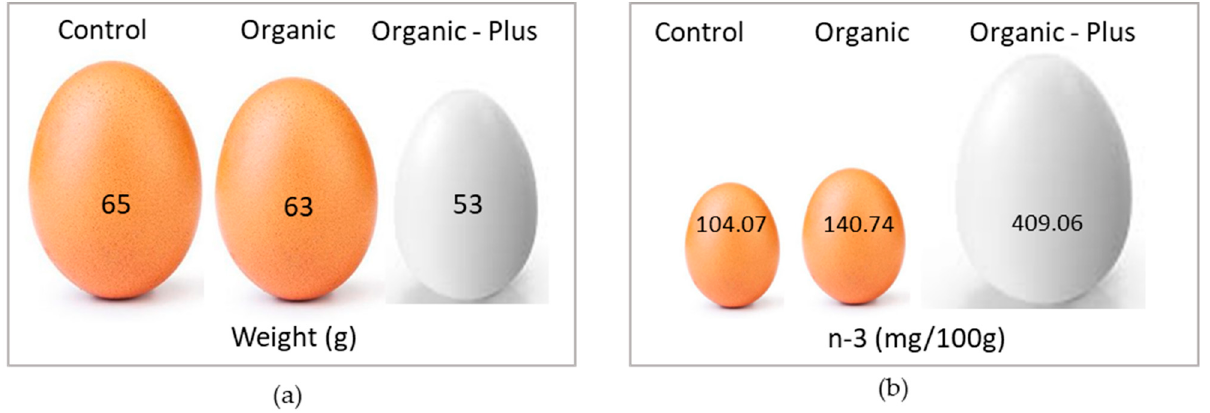
Figure 5. Comparison between ( a ) the weight (g) and ( b ) n-3 content (mg/100 g) of eggs from hens reared in conventional, organic, and organic–plus system. Conventional rearing system was characterized by commercial hens reared indoors; in the organic rearing system, commercial hens with 4 m 2 /hen of organic pasture were used, whereas organic-plus system consisted of local breed hens with 10 m 2 /hen of organic pasture. Data from Dal Bosco, 2016 [216].